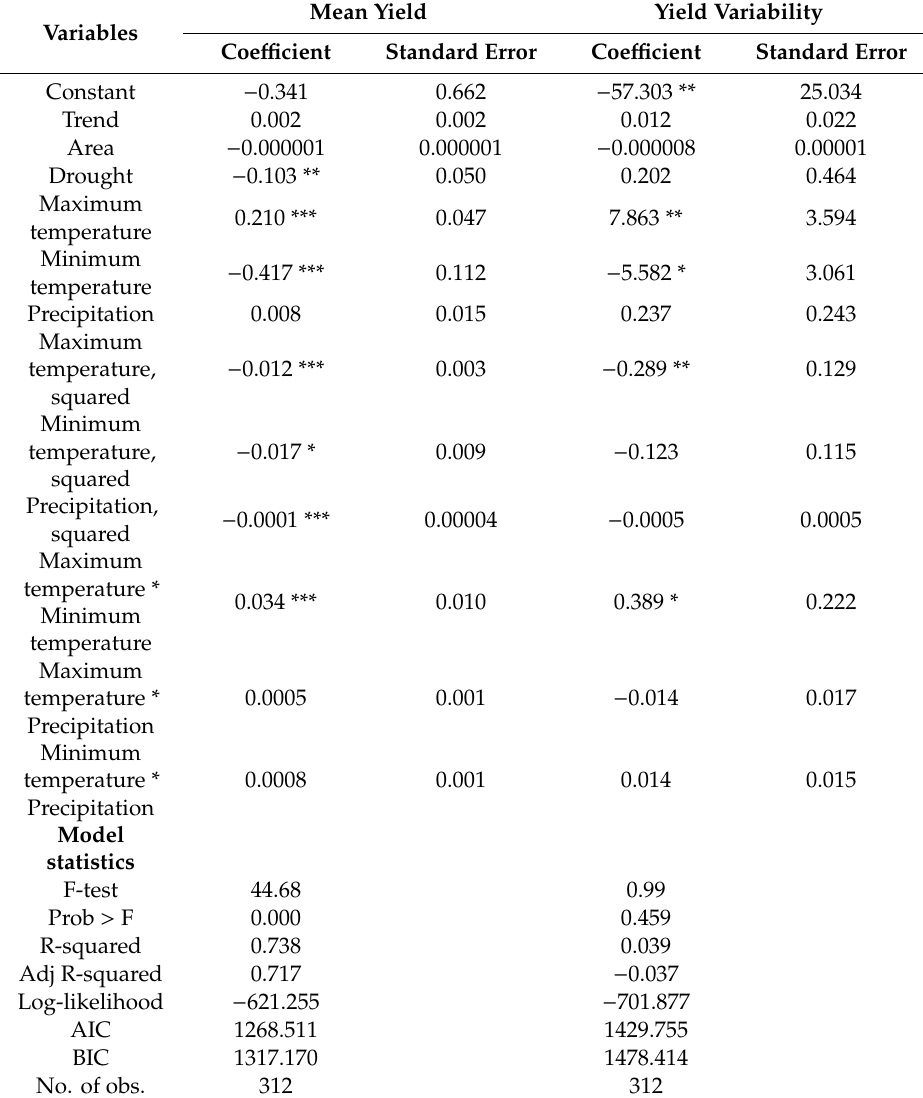
Table 7. Estimates of the impact of climatic variables on average yield and yield variability of dryland wheat, using the Just and Pope non-linear (quadratic)